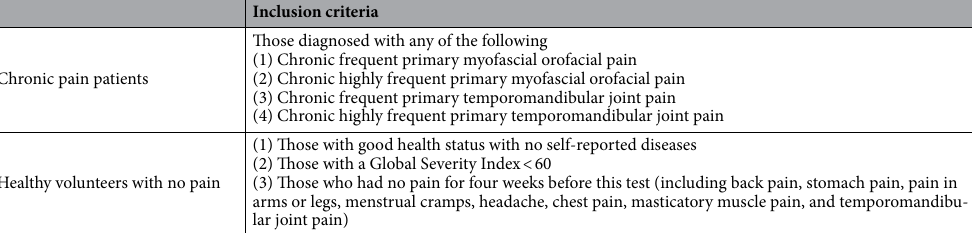
Table 1. The criteria of two groups; chronic pain patients and healthy volunteers with no pain. The general inclusion criteria of participants were: (1) willing to participate and give informed consent; (2) above 20 years of age. The general exclusion criteria were: (1) individuals unable to communicate or follow instructions; (2) use of narcotics, antidepressants, and psychotropics; and (3) individuals with paralysis or a skin disorder at hand.